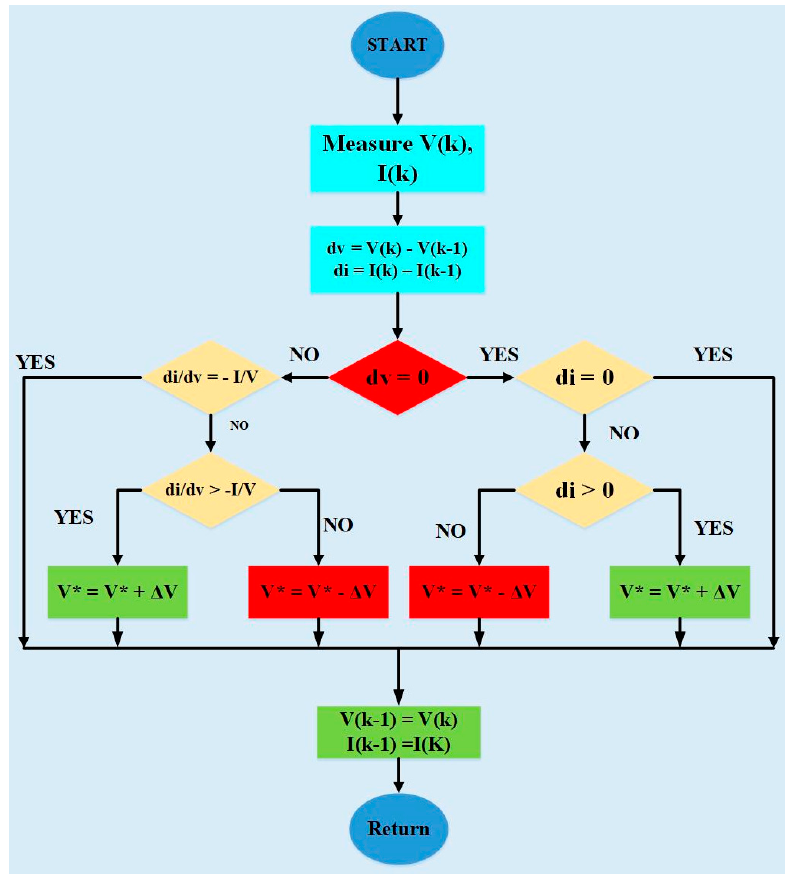
Figure 4. INC MPPT. Figure 4. INC